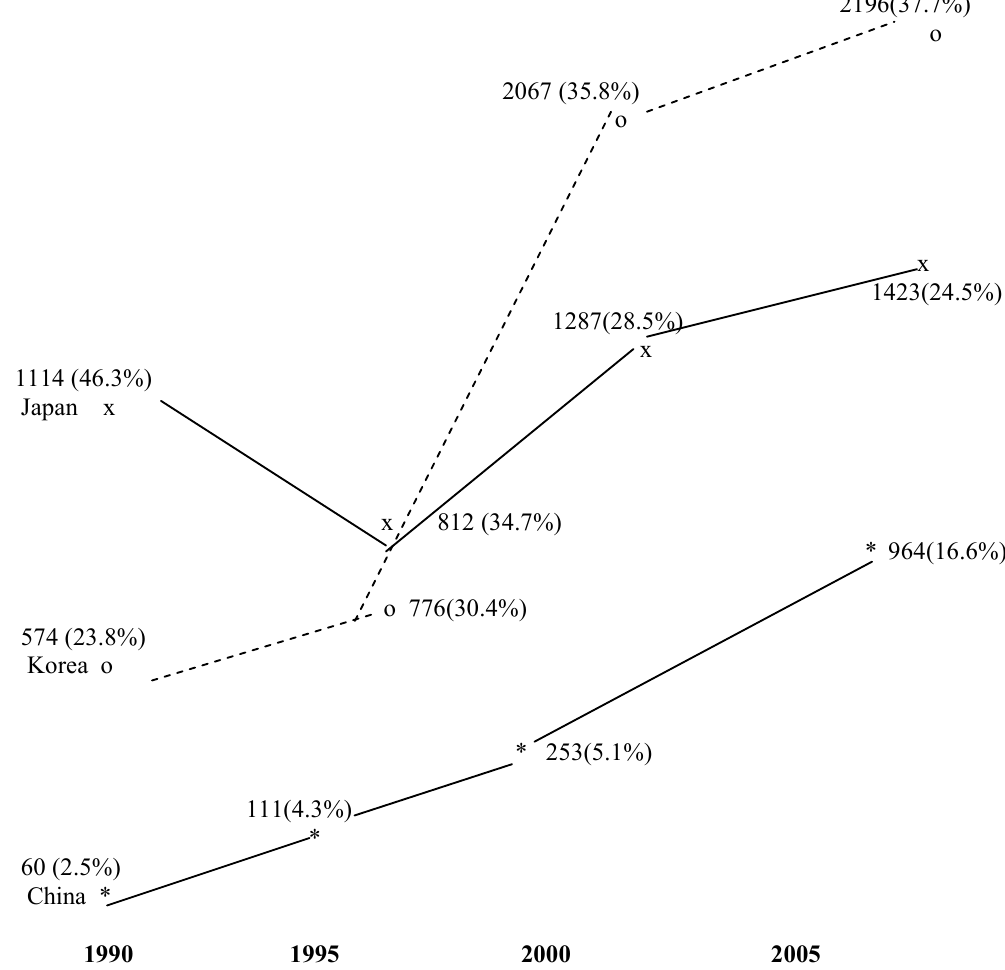
Figure 1: Shipbuilding Results by China, Japan, and